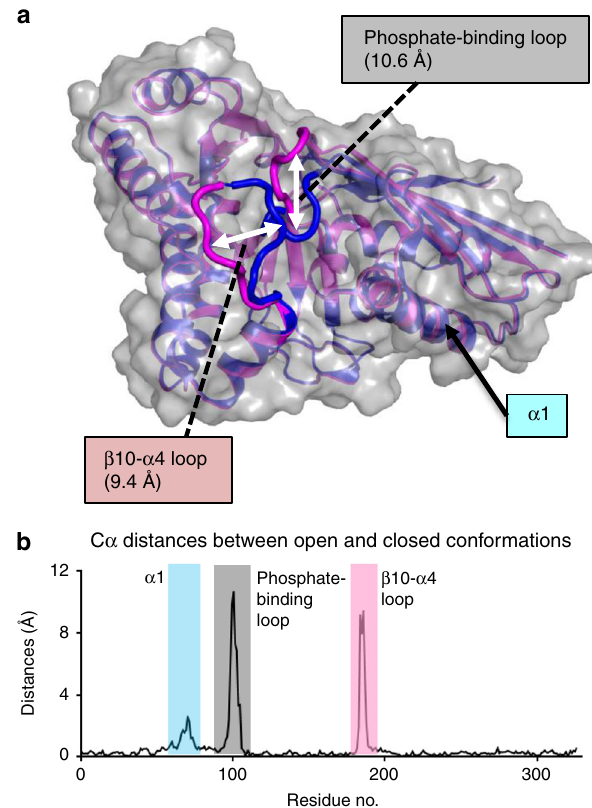
Fig. 4 Differences between open and closed MDD EF bound with ligands. a Superposition of open (MDD EF -MVAPP-AMPPCP-Mg 2 + , magenta) and closed (MDD EF -MVAPP-ADPBeF 3 -Mg 2 + , blue) conformations of MDD EF . A gray surface represents the envelope of the apo-MDD EF . The greatest distance between the β 10- α 4 loops is 9.4 Å (left white arrow) determined by measuring the distance between K187 C α carbons in the open and closed structures. The greatest distance between the phosphate-binding loops is 10.6 Å (right white arrow) determined by measuring the distance between A101 C α carbons in open and closed structures. b Distances of C α atoms between open and closed conformations. The structural models of open and closed MDD EF were C α -aligned to apo-MDD EF with r.m.s. deviation values of 0.35 and 0.40 Å, respectively. The distances between corresponding C α atoms in both structures is plotted as a function of residue number. The regions of helix α 1 ( α 1, 66 – 81), the phosphate-binding loop (97 – 104) and the β 10- α 4 loop (183 – 190) are highlighted in cyan, gray, and pink, respectively. Source data are provided as a Source Data fi taking the same position as previously assigned to the γ - phosphate.